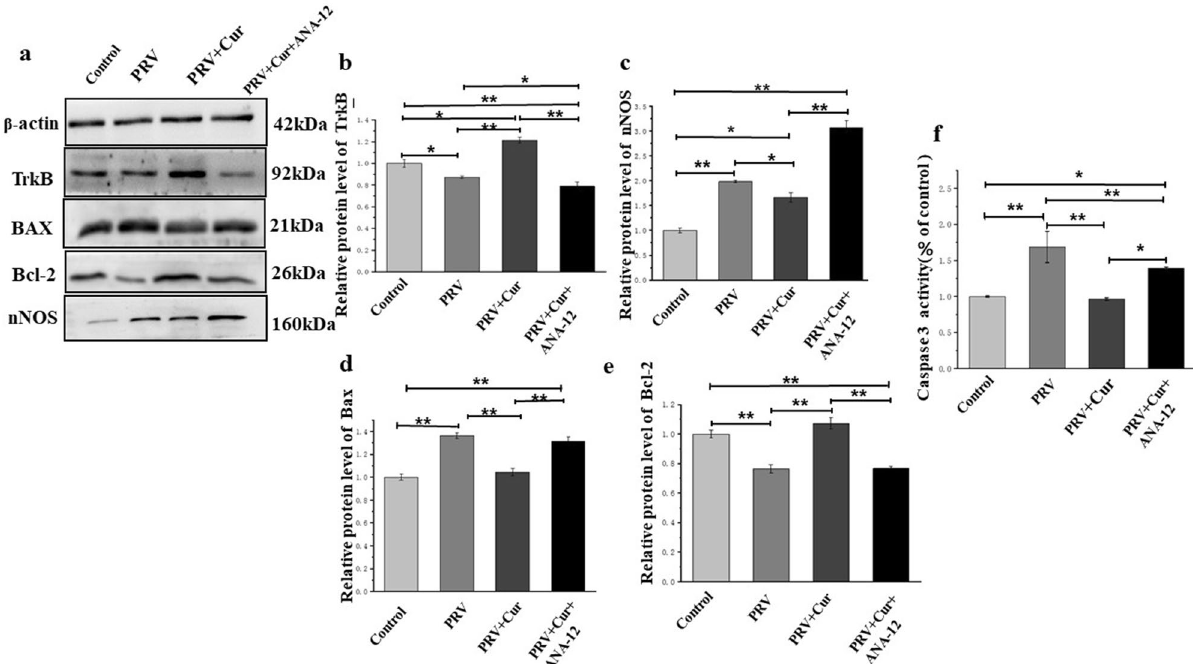
Figure 5. The protein levels of nNOS, TrkB, Bcl-2, Bax, and caspase-3 activation in hippocampal neurons. ( a ) nNOS, TrkB, Bcl-2, and Bax protein levels in hippocampus neurons were measured by western blotting, then intensity was calculated using β-actin as an internal control to normalize protein loading ( b – e ). ( f ) caspase-3 activation. nNOS neuronal nitric oxide synthase, TrkB tropomyosin-related kinase B, Bcl-2 B-cell lymphoma-2, Bax Bcl-2-associated X. n = 3, represents three biological replicates, each performed in triplicate. *P < 0.05, **P < 0.01, based on one-way analysis of variance (ANOVA) followed by least significant difference (LSD) post hoc test for multiple